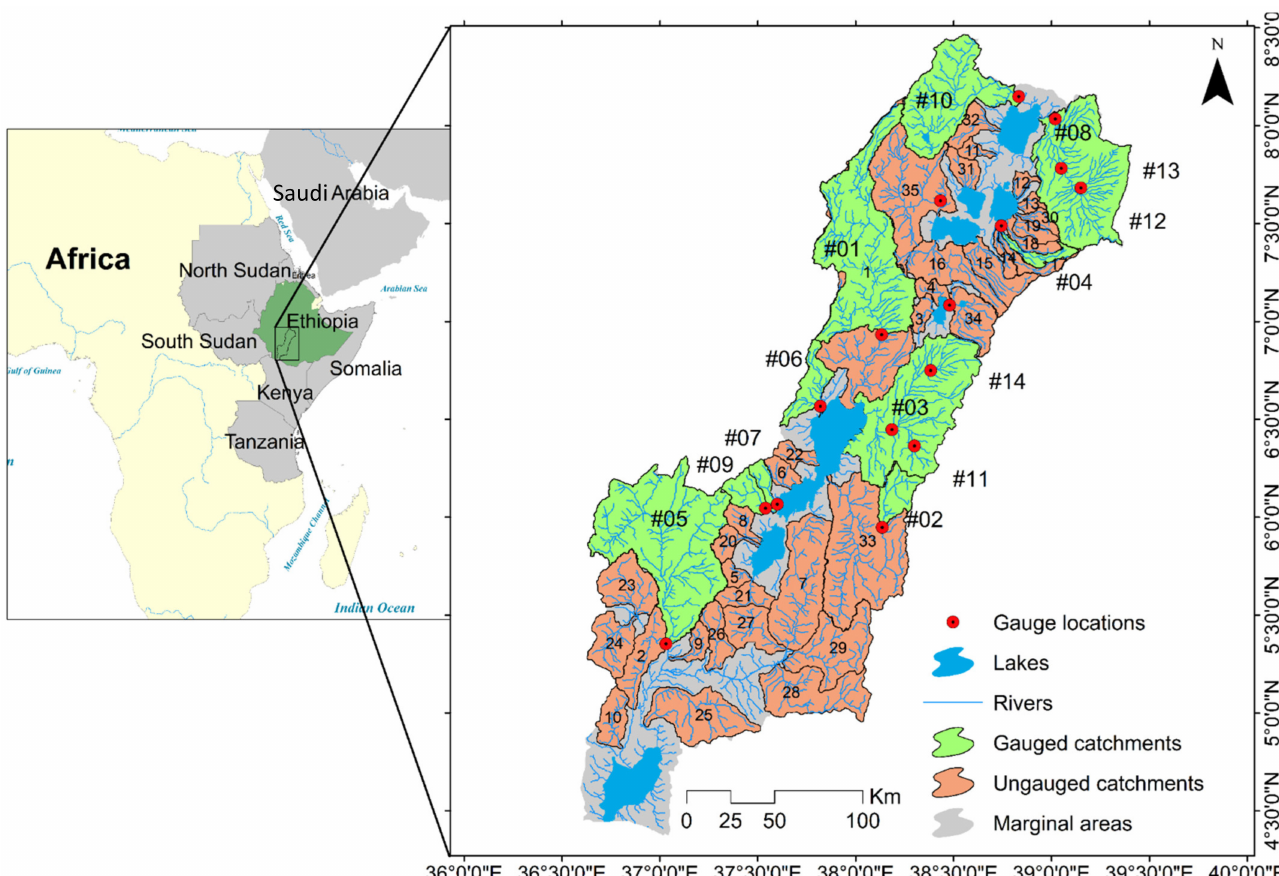
Figure 1. The study basin showing 14 gauged catchments for the regional model development and 35 ungauged catchments that are draining to the respective lakes through the river